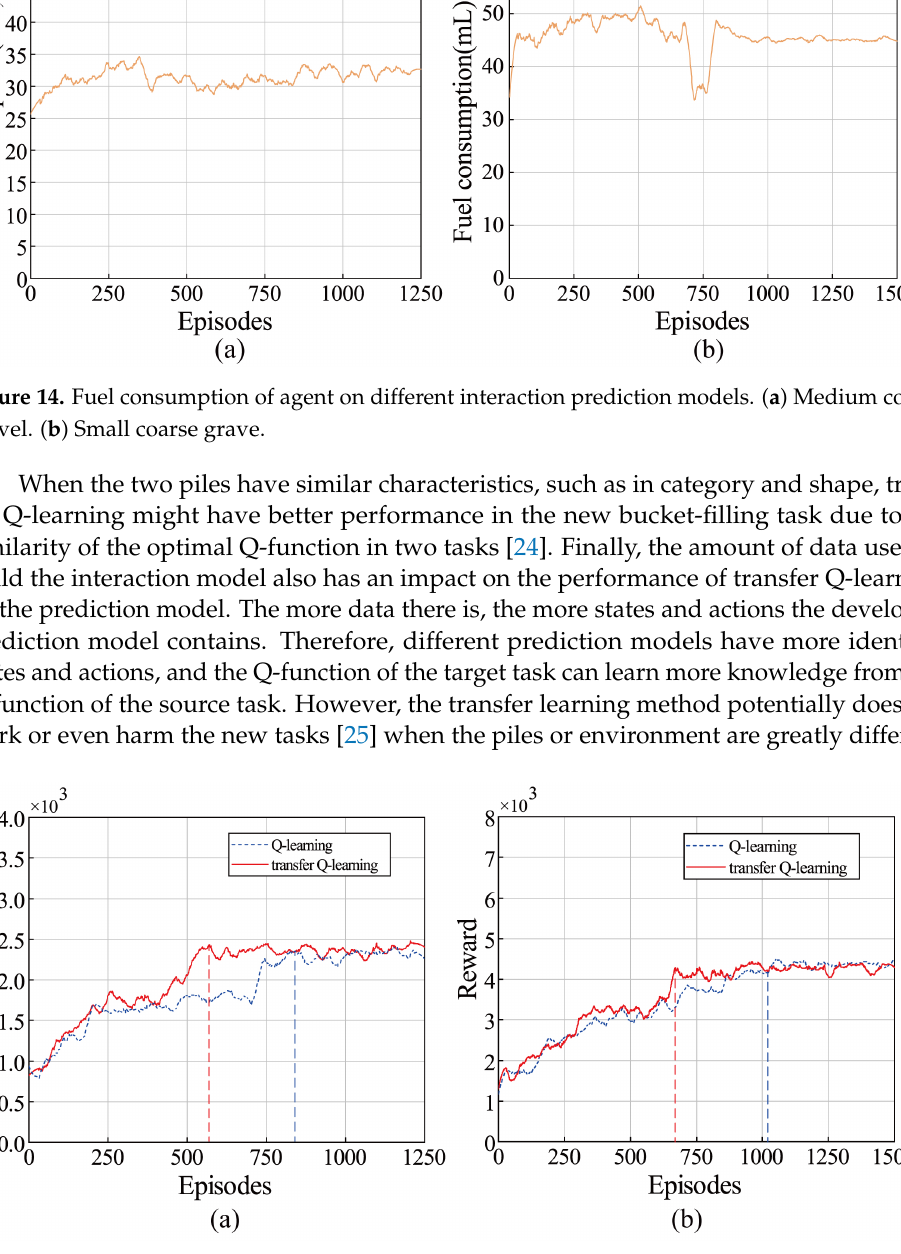
Figure 15. Comparison between Q-learning and transfer Q-learning. ( a ) Q-learning is only trained on the MCG-pile interaction prediction model, and transfer Q-learning is first trained on the SCG- pile interaction prediction model and then trained on the MCG-pile interaction prediction model. ( b ) Q-learning is only trained on the SCG-pile model, and transfer Q-learning is first trained on the MCG-pile model and then trained on the SCG-pile interaction prediction model. Table 3. The comparison of Q-learning and transfer Q-learning on convergence